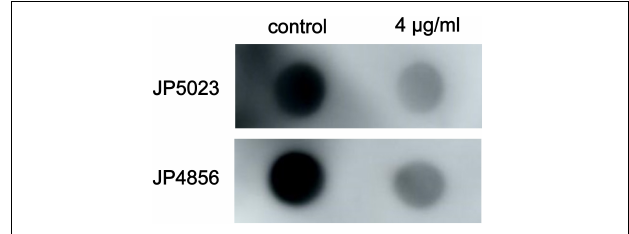
biofilm by an attachment assay. The results showed that SYG- 180-2-2 significantly suppressed the adhesion of JP5023 and JP4856 to the solid surface at 4 µ g/ml by 37.6 ± 9.3 and 21.4 ± 5.1%, respectively ( Figure 8 ). Meanwhile,